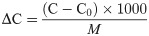
Summary of the mass flow during bioconversion of Pin and/or PDG from glucose (a), phenylalanine (b), cinnamic acid (c), p-coumaric acid (d), and leucine (e).The data shown in the figure indicate the initial amount (Arial Bold type) and the consumed amount (Arial italic type) of the substrates, the amount of metabolic flux of the substrates to the presented pathway (Arial italic with underline type) and the highest productions of the substrates (Times normal type). The unit is μmol/L for all present values. Values presented here are the mean of three replications with standard deviation. The values were calculated according to Eq (1).
ΔC=(C−C0)×1000M(1)
Where, the letters indicate the corresponding data of each substrate, specifically, △C is the highest amount (μmol/L) of the products during the bioconversion, C is the highest amount (mg/L) after the bioconversion, C0 (mg/L) is the initial amount, and M (μg/μmol) is the molecular weight. The abbreviations in the figure mean glucose (Glu), leucine (Leu), phenylalanine (Phe), tyrosine (Tyr), cinnamic acid (Ca), p-Coumaric acid (pC), pinoresinol (Pin), and pinoresinol diglucoside (PDG).